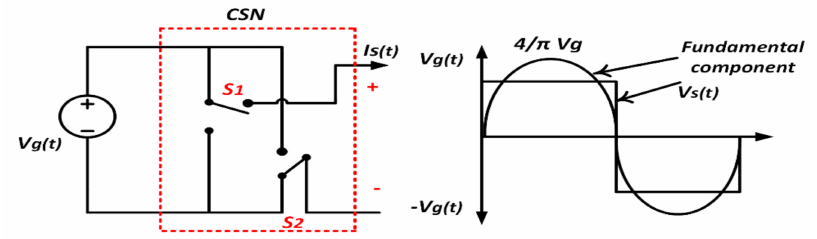
Figure 18. Equivalent circuit of CSN